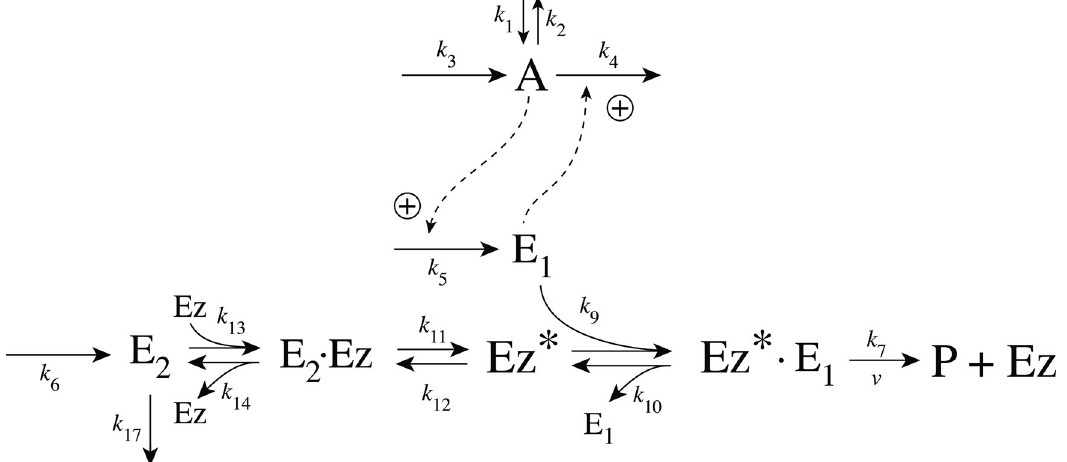
Fig 48. Scheme of the m5 controller when E 1 and E 2 are removed by a ping-pong mechanism with E 2 binding first to the free enzyme Ez .